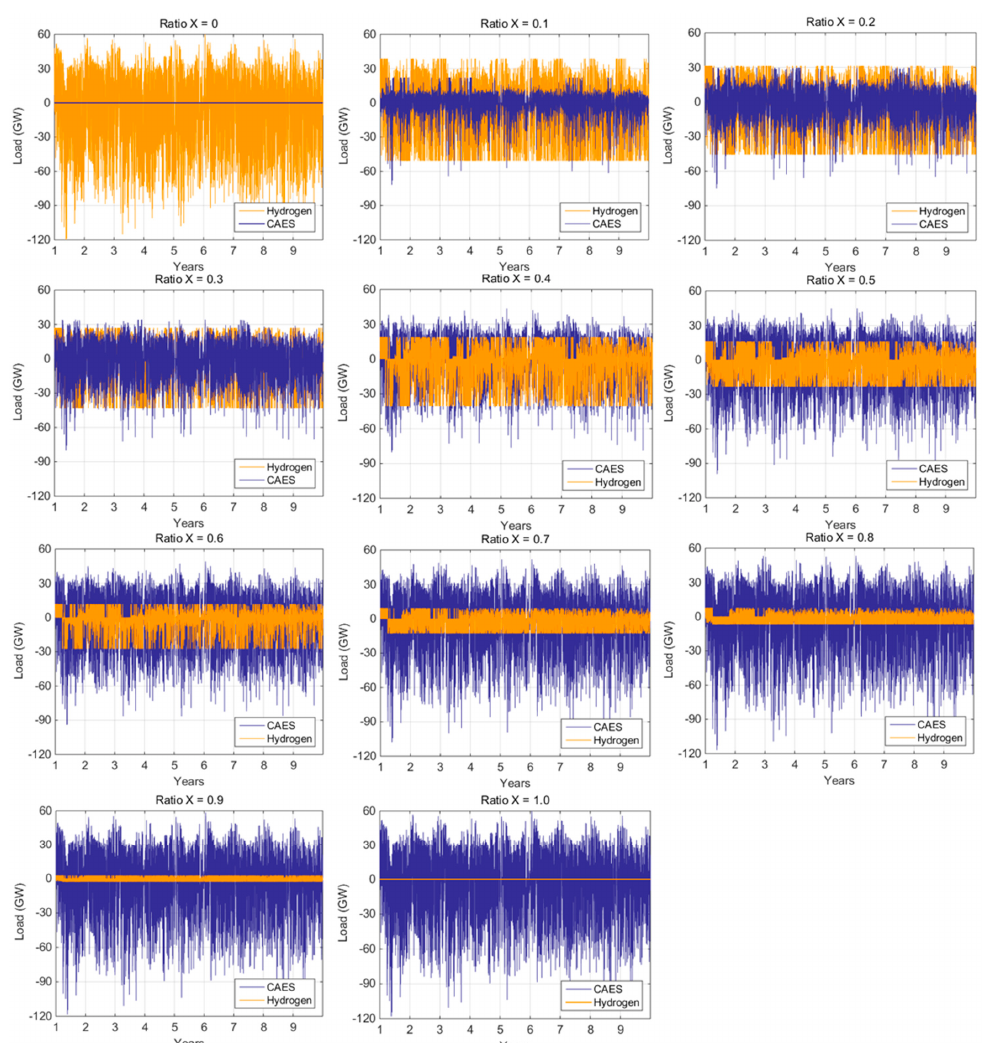
Figure 8. CAES and H 2 work cycles for different values of X , after modifications by post-split optimization functions.